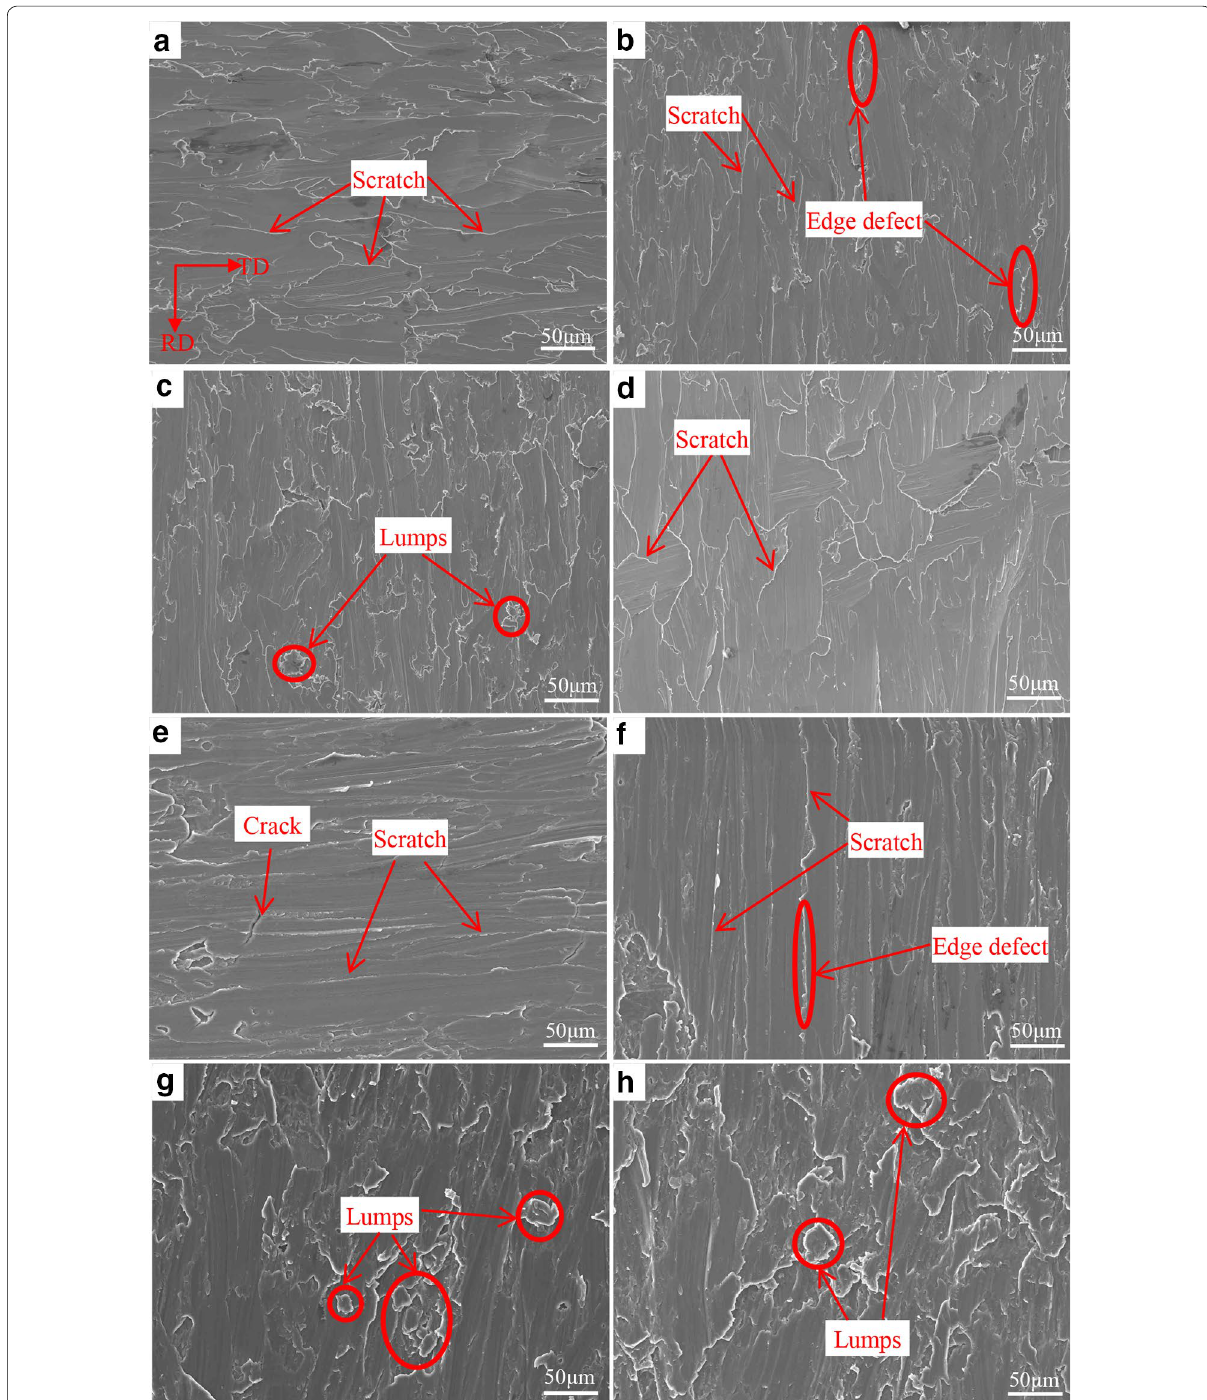
Fig. 2 Surface morphology after treatment for 20 s: a VRDG/Cu; b PRDG/Cu; c 90° CG/Cu; d RWBG/Cu; e VRDG/Al; f PRDG/Al; g 90° CG/Al; h RWBG/